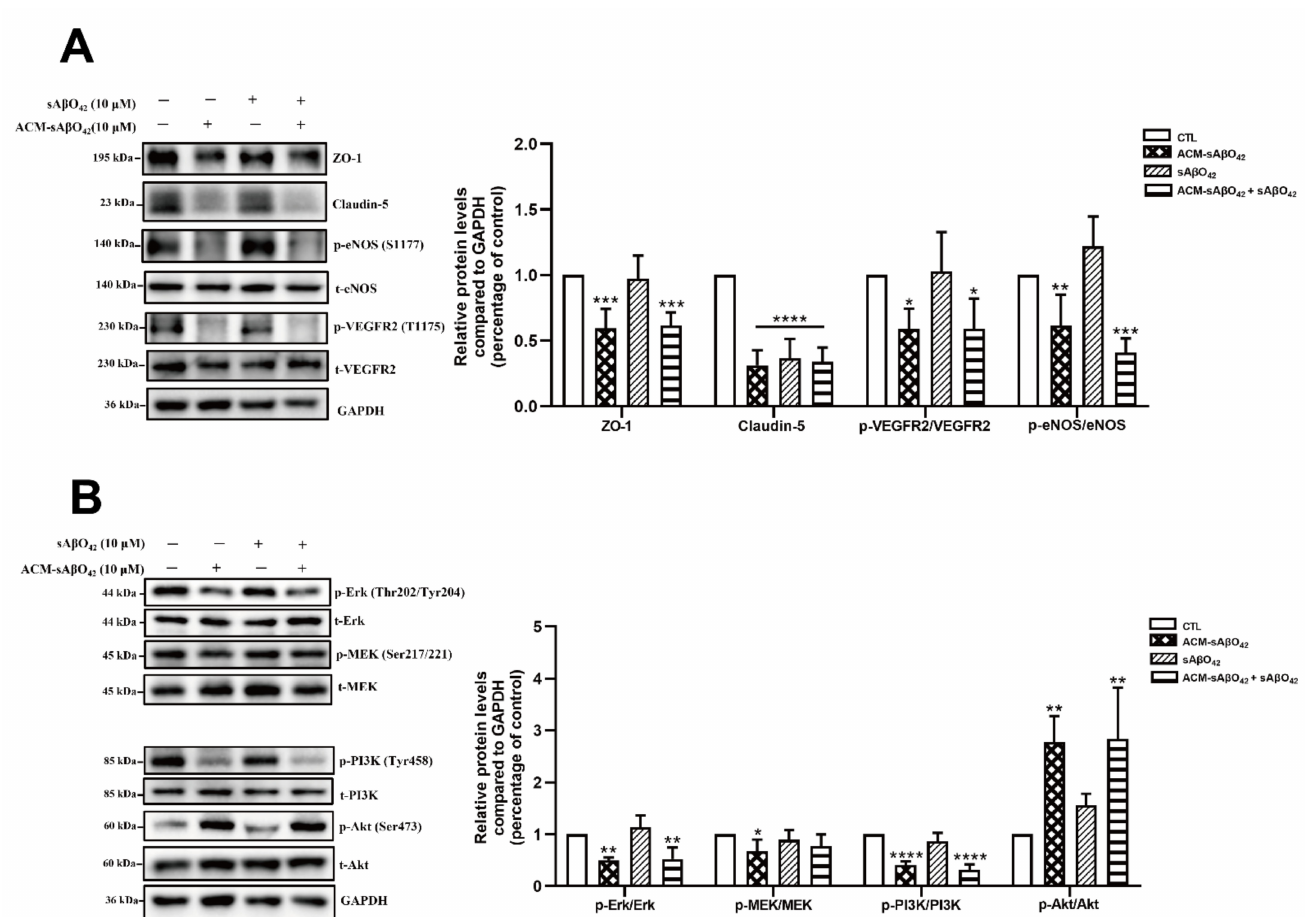
Figure 10. Effects of ACM sA β O42 and exogenous sA β O42 (alone or in combination) on endothelial junctions, eNOS, and vascular endothelial growth factor 2 (VEGFR2) pathways in bEnd.3 cells. ( A ) The protein expression levels of ZO-1, claudin-5, and the ratio of protein expression levels of p-VEGFR2/VEGFR2 and p-eNOS/eNOS in bEnd.3 cells upon the exposure of ACM-sA β O42 (10 µ M) and sA β O42 (10 µ M) for 24 h. ( B ) The ratio of protein expression levels of p-Ras/Raf/Mitogen- activated protein kinase/ERK kinase (MEK)/t-MEK, p-extracellular-signal-regulated kinase (Erk)/t- Erk, p-phosphoinositide 3-kinase (PI3K)/t-PI3K, and p-serine/threonine kinase Akt (Akt)/t-Akt. Data are shown as means ± SD of at least three independent experiments and were analyzed by one- way ANOVA followed by a post hoc Dunnett’s test. * p ≤ 0.1, ** p ≤ 0.01, *** p ≤ 0.001, **** p ≤ 0.0001 vs. control